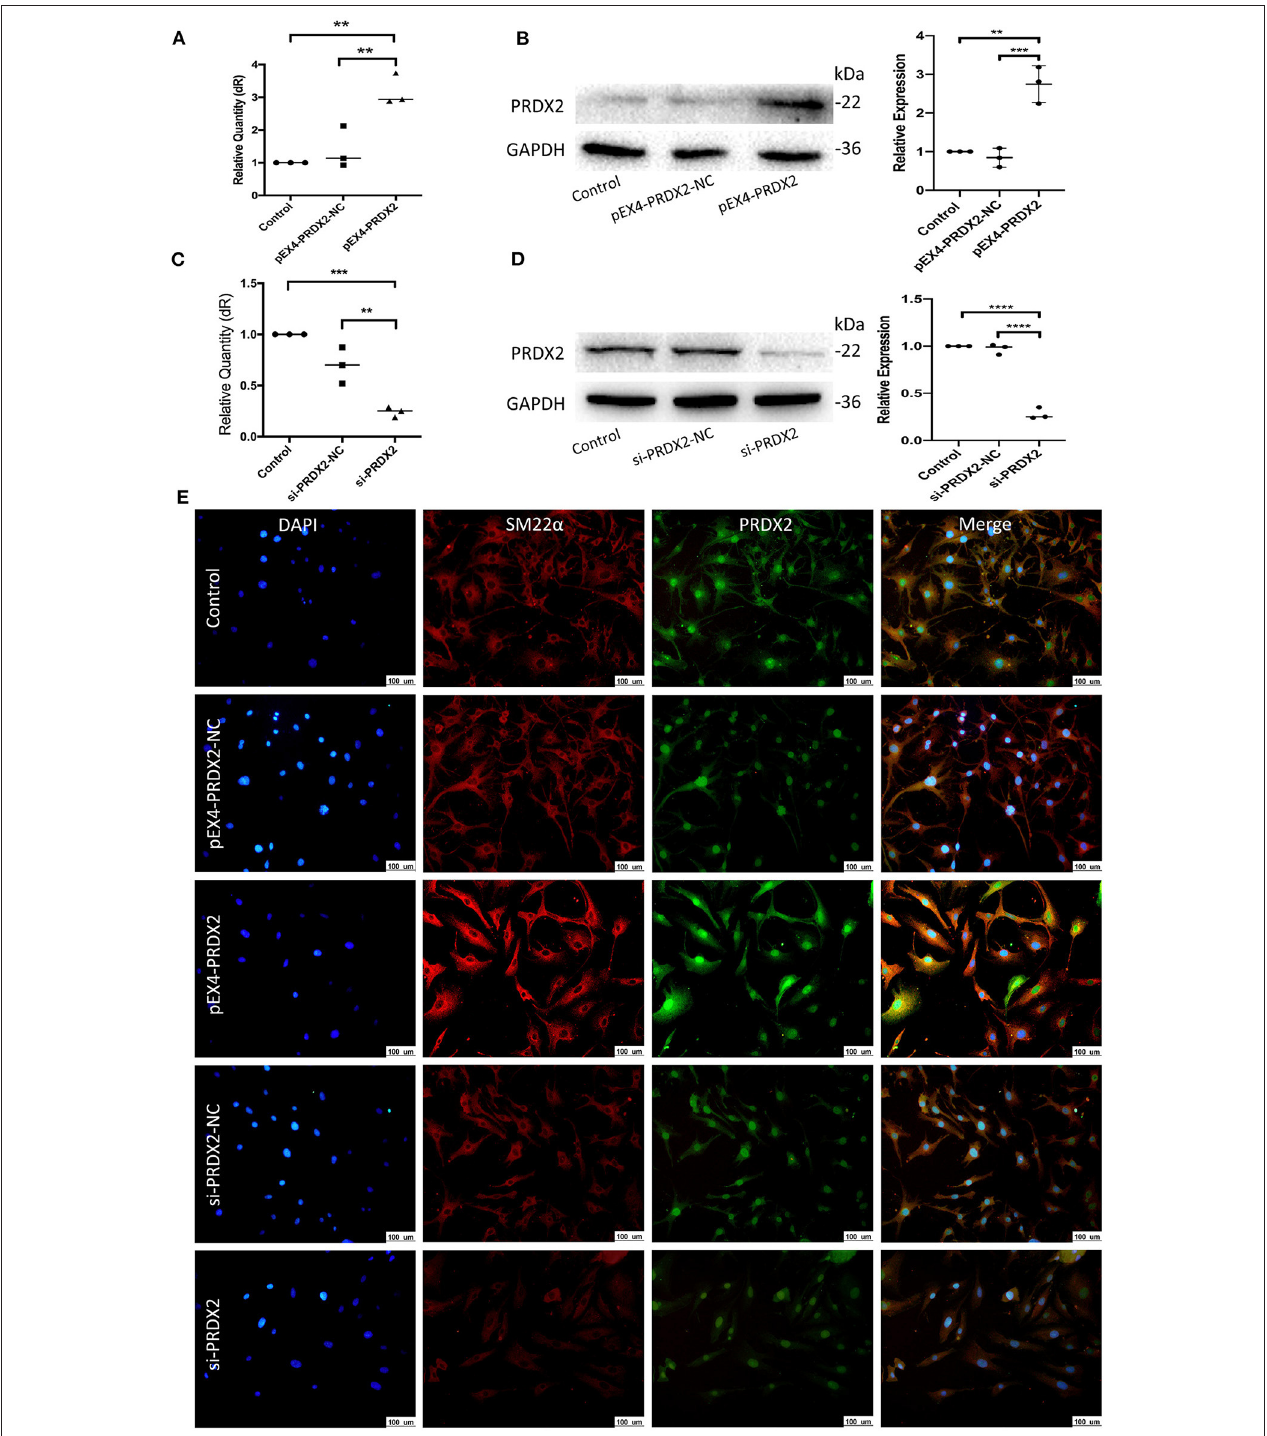
FIGURE 3 | Successfully regulate PRDX2 in the CAVSMCs. (A) PRDX2 expression was assessed by qRT-PCR. (** p < 0.01 vs. control group and NC group). (B) Expression levels of PRDX2 protein in different groups according to Western blot (** p < 0.01 vs. control group and *** p < 0.001 vs. NC group). (C) PRDX2 expression were assessed by qRT-PCR (*** p < 0.001 vs. control group and ** p < 0.01 vs. NC group). (D) PRDX2 protein expression in different groups was determined by Western blot (**** p < 0.01 vs. control group and NC group). (E) Representative confocal immunofluorescence pictures of SM22 α (red) and PRDX2 (green). Nuclei were stained with DAPI (blue). Scale bar: 100 µ